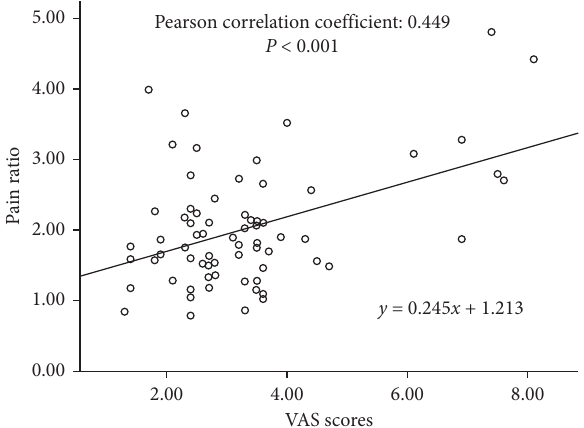
Figure 2: Pain vision system measured pain ratio after treatment was linearly correlated with patient VAS